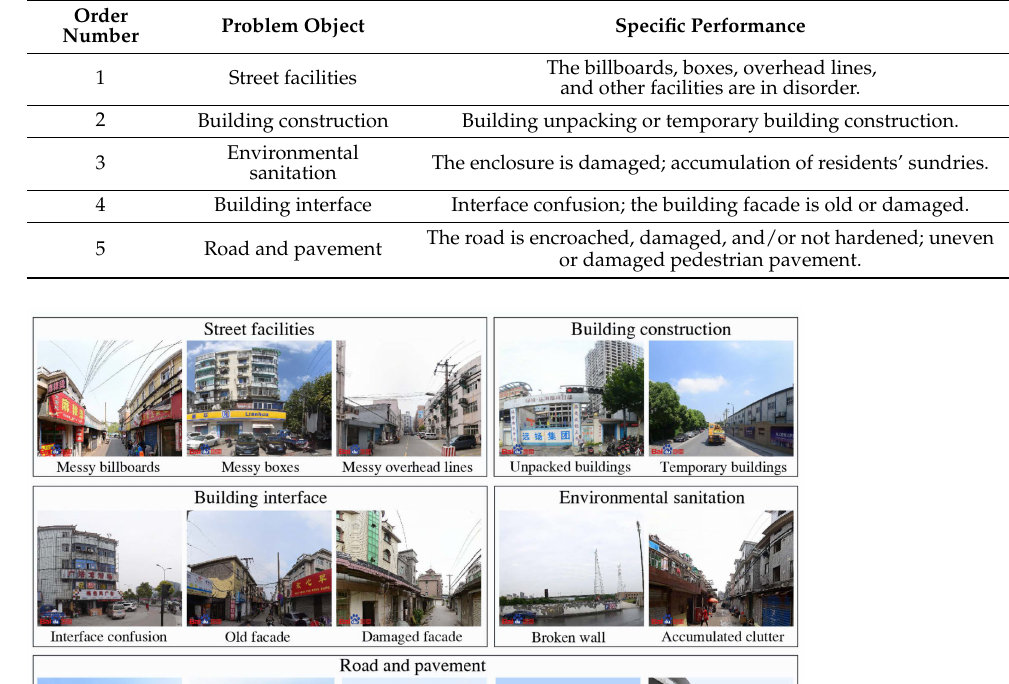
Table 2. List of street spatial quality problems.